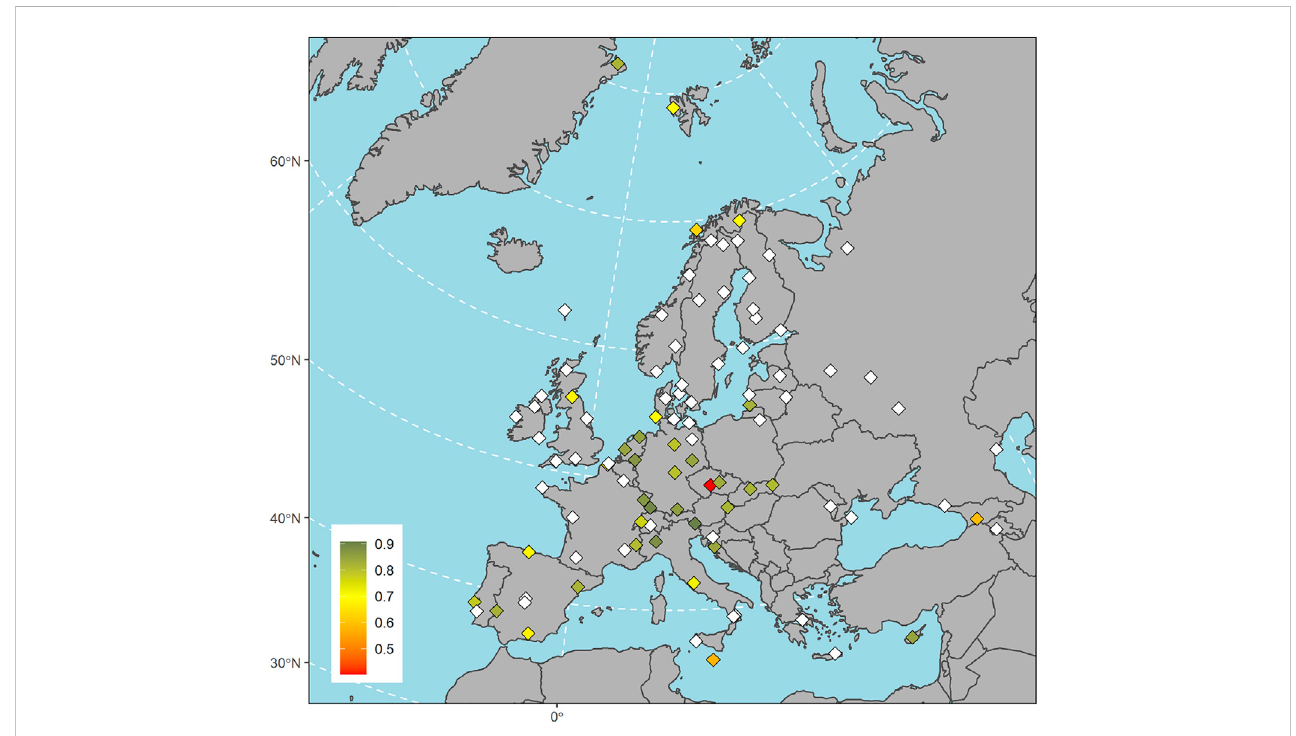
FIGURE 2 The fraction of the anti-DP isomer (f anti = anti-DP/( Ʃ DP)) in samples where both the anti- and the syn-DP isomers are present. Sample locations where one or both DP isomers were below MDL are shown as white points. The commercial mixtures of DP have a f anti between 0.59 and 0.80 (Wang et al., 2010).